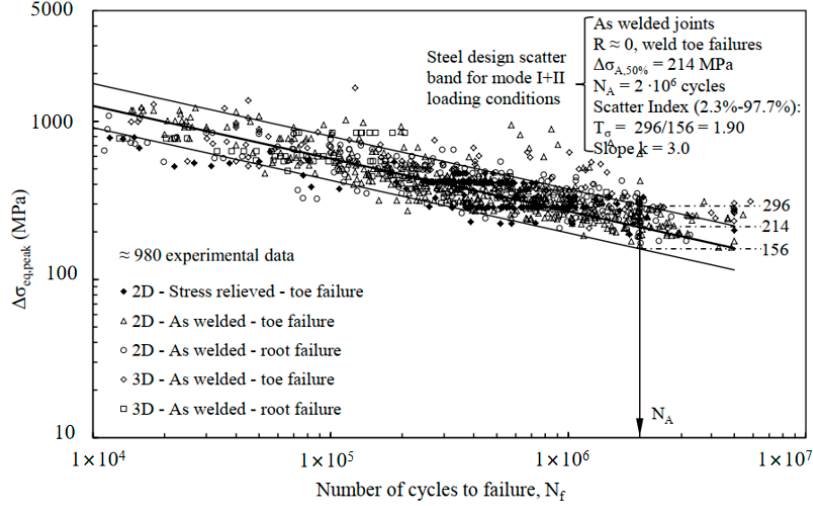
Figure 4. Steel design scatter band for Mode I + II loading conditions [10].